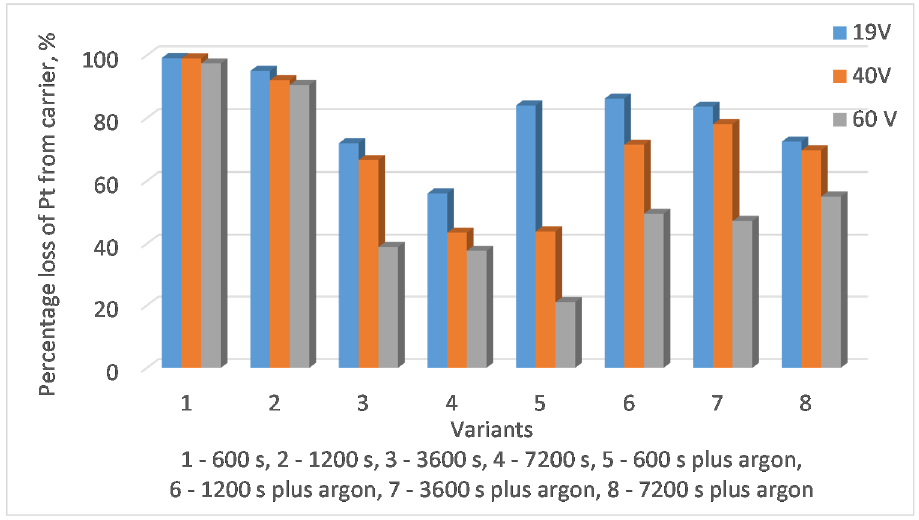
Figure 7. Results of percentage platinum washed from carriers in different variants, considering time of washing and argon blowing for three different secondary voltage on transformer covers.